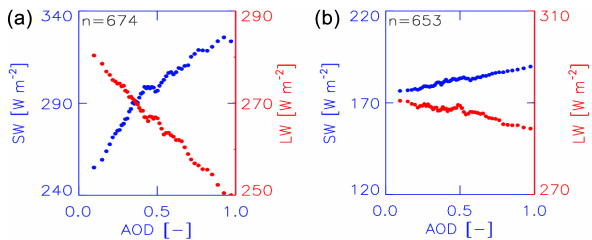
Figure 4. Association of CERES-retrieved incoming shortwave (SW) and outgoing longwave (LW) radiation with AOD for (a) the all-sky and (b) the clear-sky scenario over the ISMR during JJAS 2002–2013. The collocated data points for both SW and LW as a function of AOD were first sorted. The total number of collocated data points (50 × n ) is then used to create 50 AOD bins of “ n ” num- ber of samples (2 percentiles) each. Each scatter point is the average of these equal “ n ” numbers of data points mentioned in each respec- tive